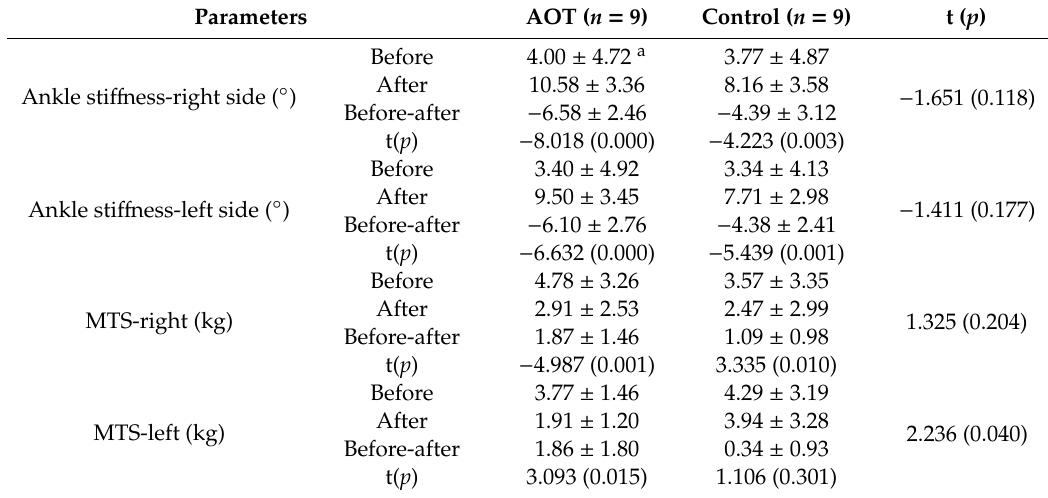
Table 3. Di ff erences in spasticity of ankle joint ( N =